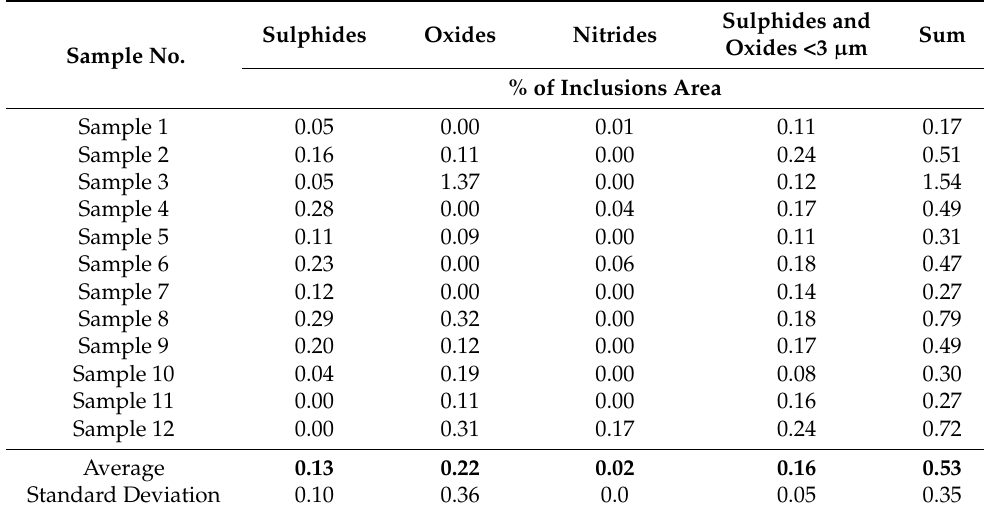
Table 4. Results of research on the quantitative distribution of inclusions in 18CrNiMo7-6 steel. Sulphides Oxides Sample No.